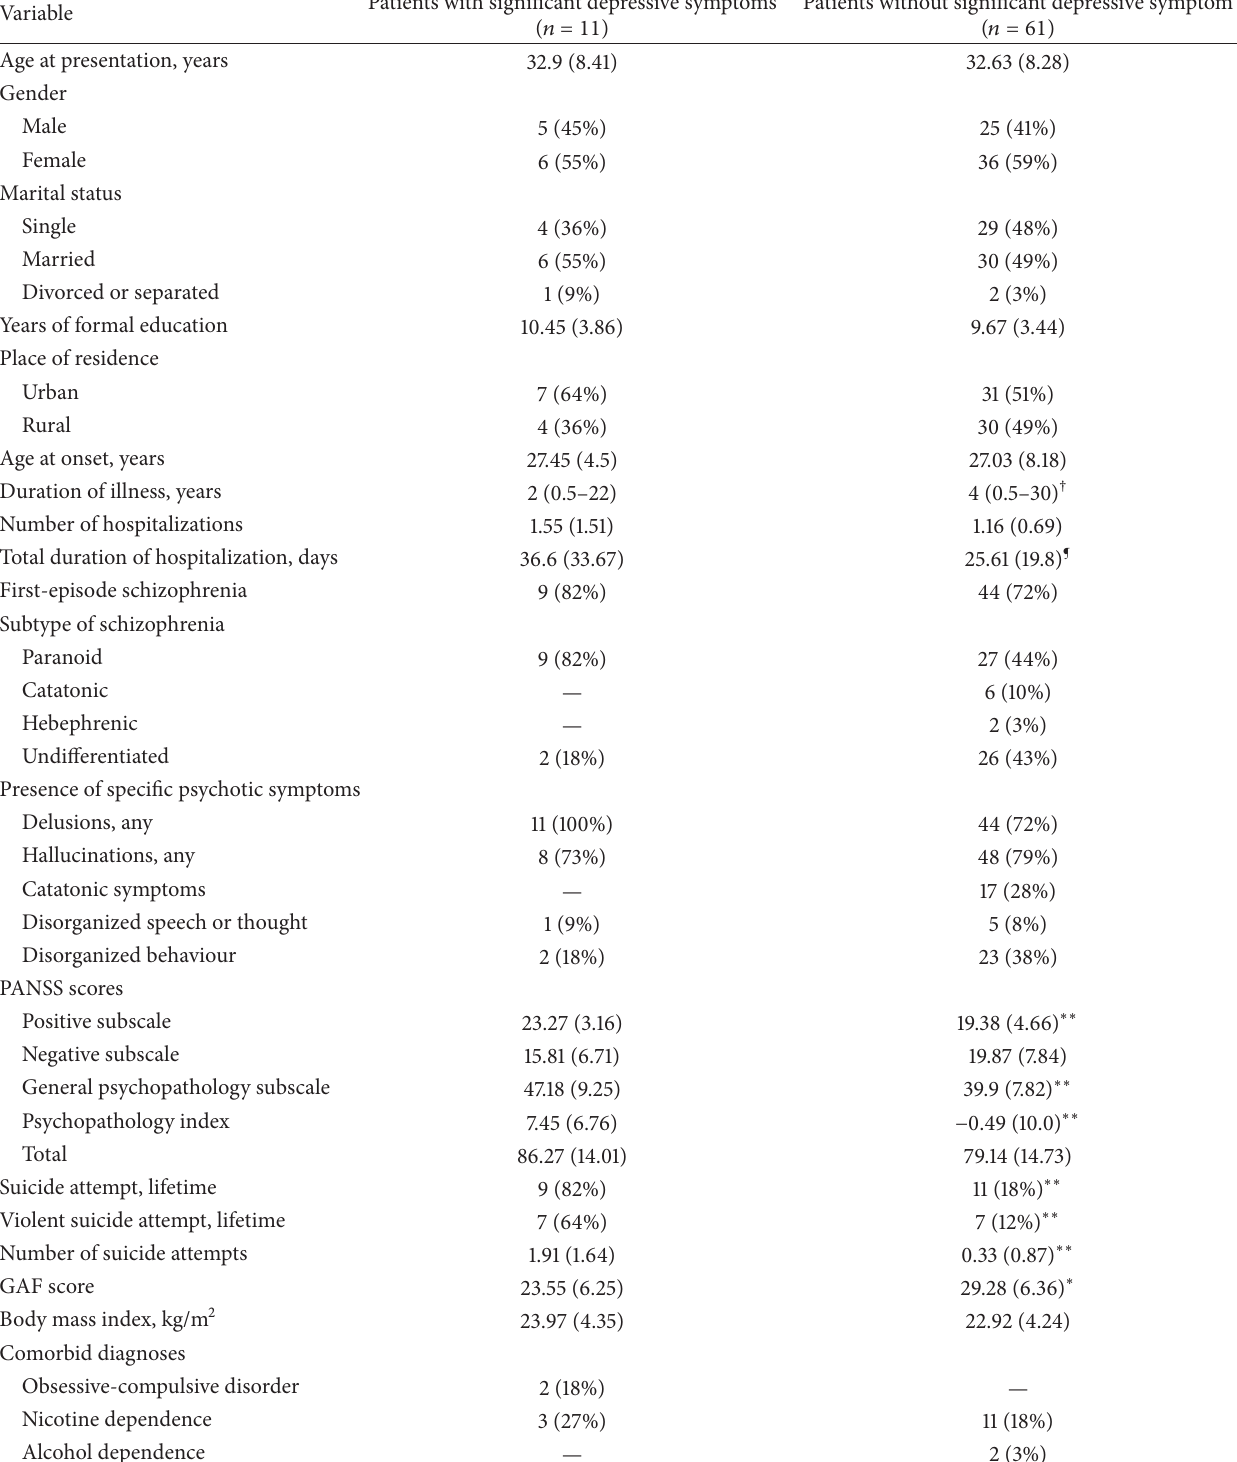
Table 1: Comparisons between patients with and without clinically significant depressive